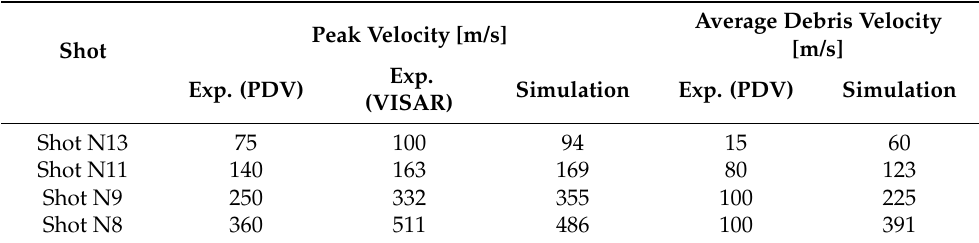
Table 5. Comparison between the speed data of the PDV and VISAR measurements (adapted from [28]) and of the numerical simulations.